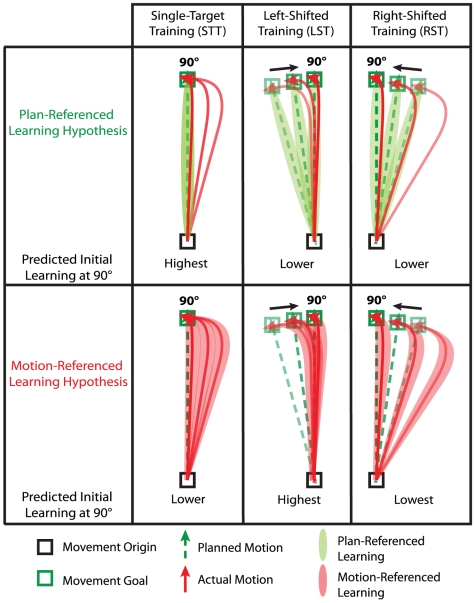
Illustration of different training paradigms under the two credit assignment hypotheses.Single-target training (STT): a single target location is presented during the training period. The PRL hypothesis predicts alignment of credit assignment across trials for STT, whereas MRL predicts misalignment. Left-shifted training (LST): targets are initially presented leftward of the desired learning direction and are brought closer to it as training progresses so that the actual motion matches the desired learning direction throughout the training period. The MRL hypothesis predicts alignment of credit assignment across trials for LST, whereas PRL predicts misalignment. Correspondingly, PRL predicts that STT will yield the greatest learning whereas MRL predicts that LST will yield the greatest learning. Right-shifted training (RST): the training targets are presented in a sequence that mirrors LST. Both the PRL and MRL hypotheses predict misalignment for RST. However, PRL predicts an identical amount of misalignment for LST and RST, whereas MRL predicts much greater misalignment for RST than LST. Note that CW FF training is illustrated in all panels.